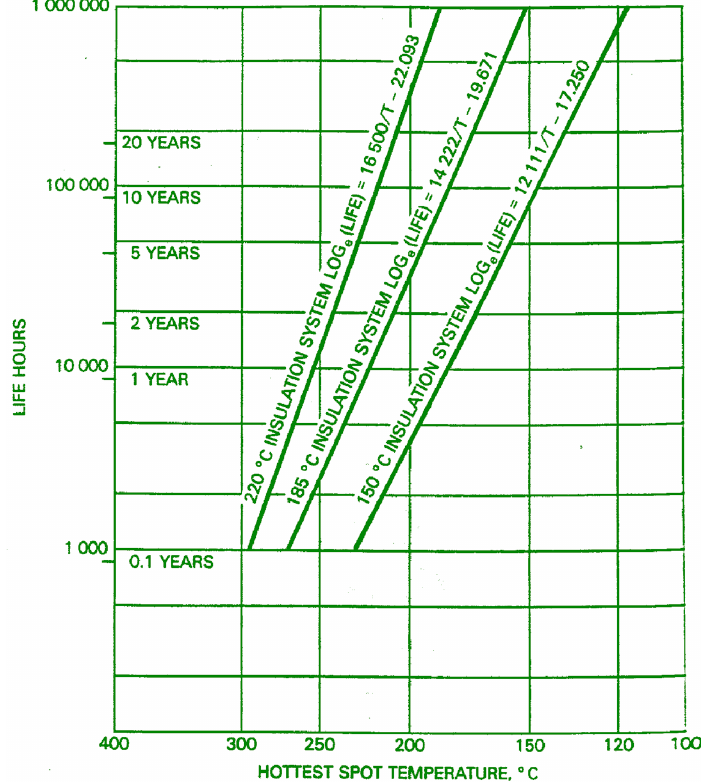
Figure 6. Life hours and hottest spot temperature °C in transformers by LOG10